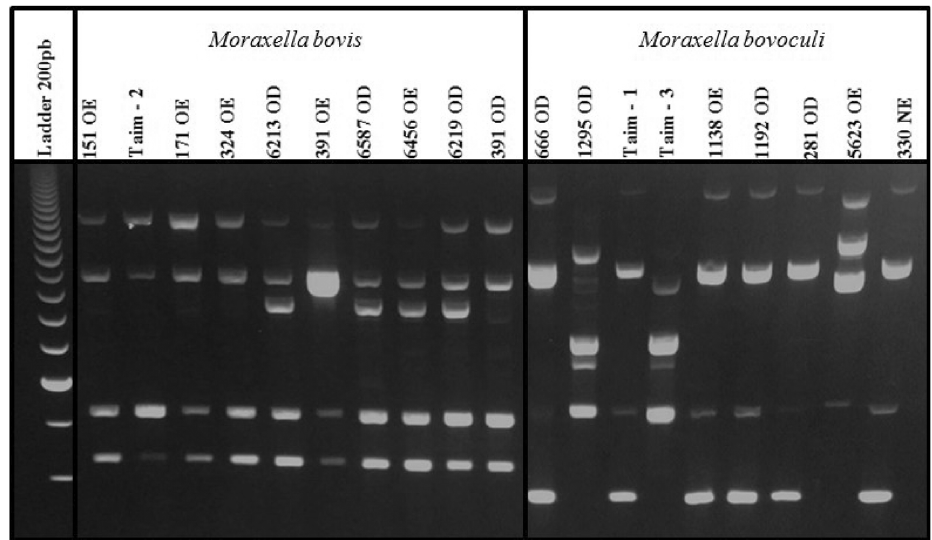
Figure 1 - Example of RAPD technique using a single primer (OPA-03). After RAPD-PCR, ten samples of M. bovis (left side) and nine samples of M. bovoculi (right side) were run in an agarose gel and stained with ethidium